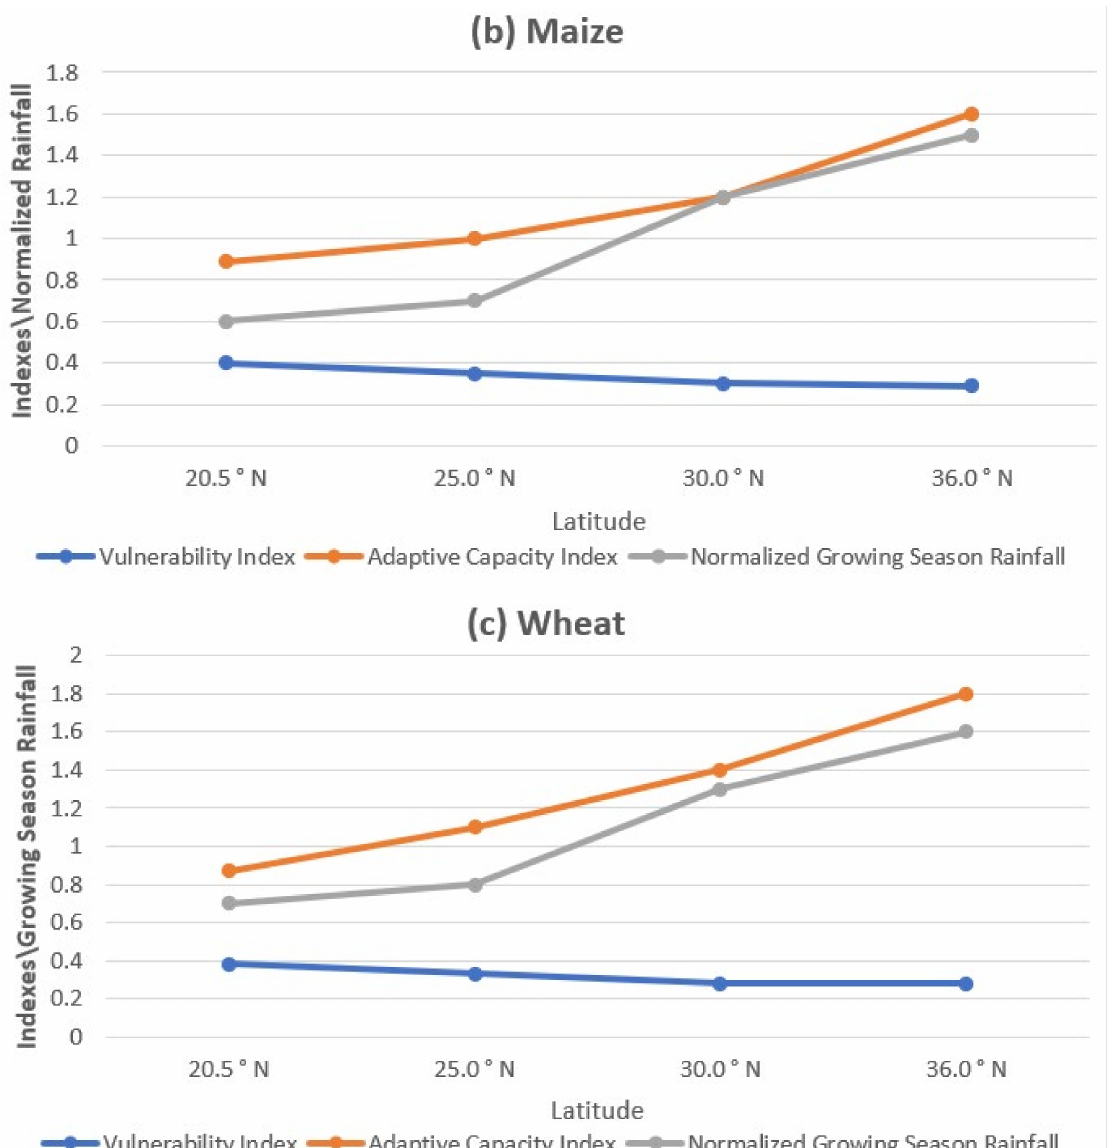
Figure 11. Spatial/latitudinal variations in vulnerability indexes, adaptive capacity indexes, and normalized rainfall for ( a ) barley, ( b ) maize, and ( c ) wheat in